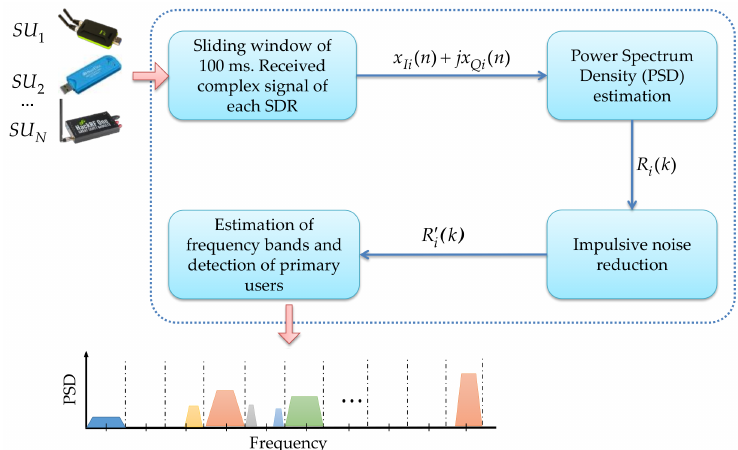
Figure 1. General description of implemented MBSS